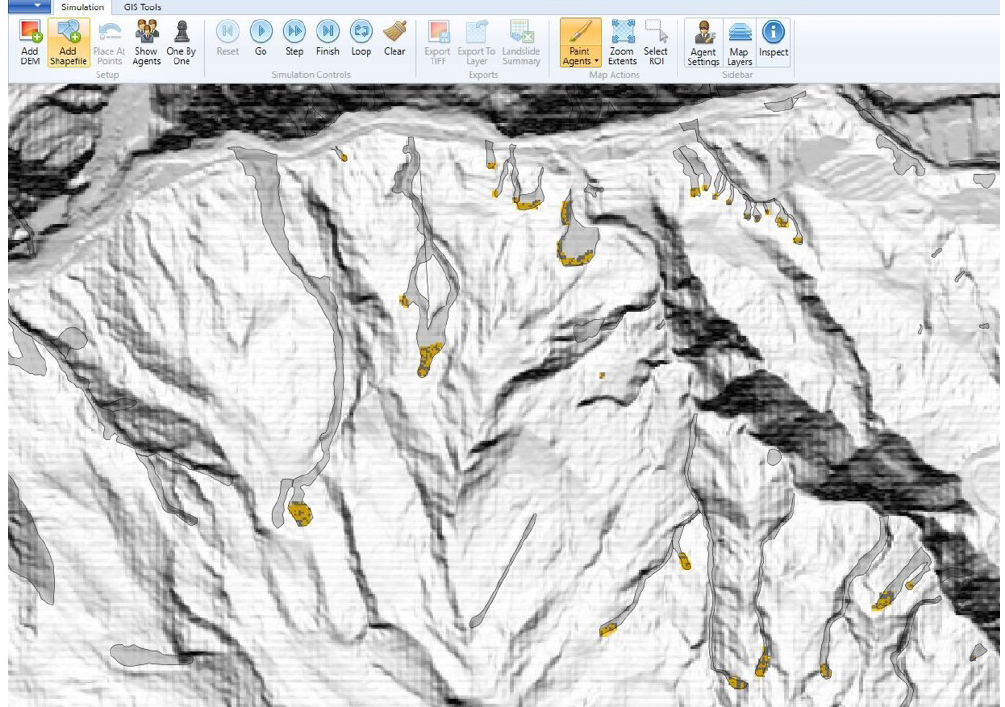
Figure 10. Landslide initiation zones painted (yellow) at the estimated source of mapped debris flows (darker line work) in DebrisFlow Predictor. Table 3. Accumulated landslide-generated sediment (in m 3 ) between known debris flood